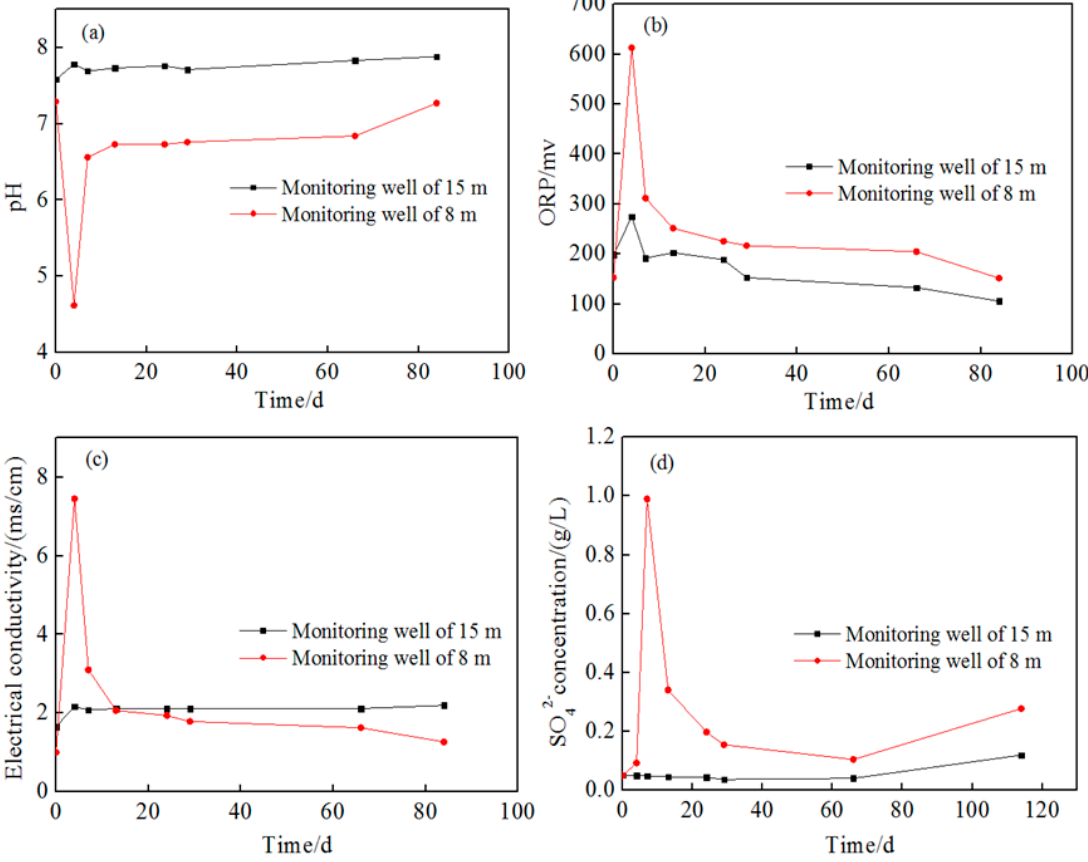
Figure 7. Change of geochemical parameters at monitoring wells 2 m downstream. ( a ) pH; ( b ) oxidation–reduction potential (ORP); ( c ) electrical conductivity; ( d ) the concentration of SO 42 −